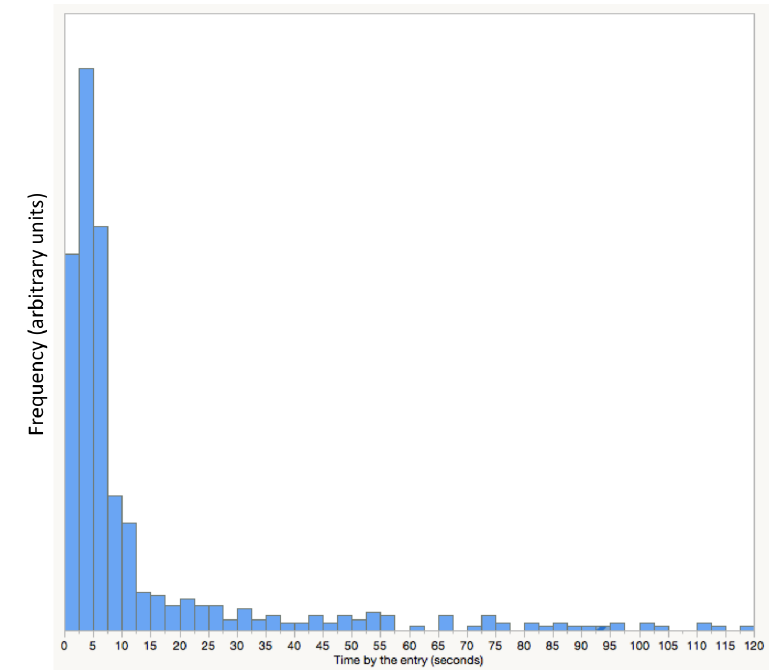
Figure 10. Distribution of duration worker honey bees were detected at the entry of the hive. The graphic shown has a period limited to two minutes, however some bees can stay longer.